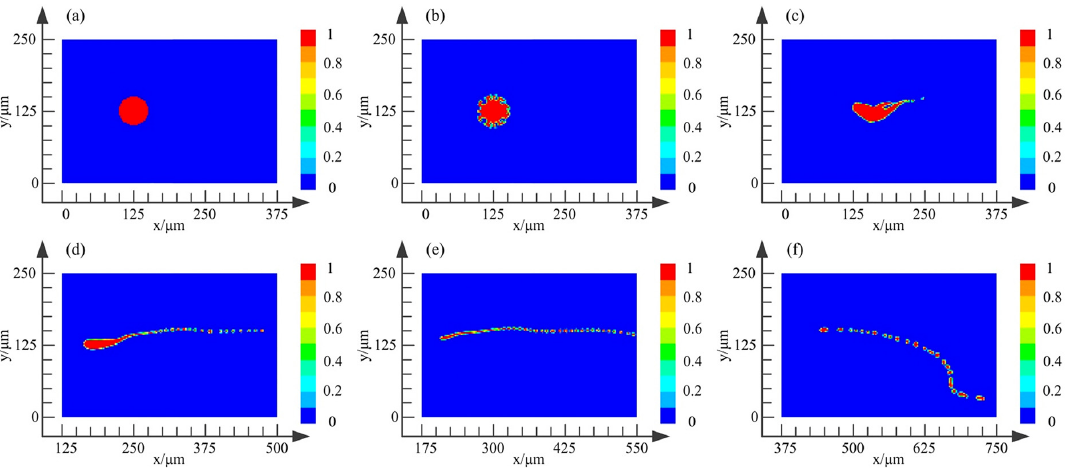
Figure 7. Volume fraction profiles of the bubble bursting near the wall: (a) t = 0 μ s, (b) t = 6 μ s, (c) t =